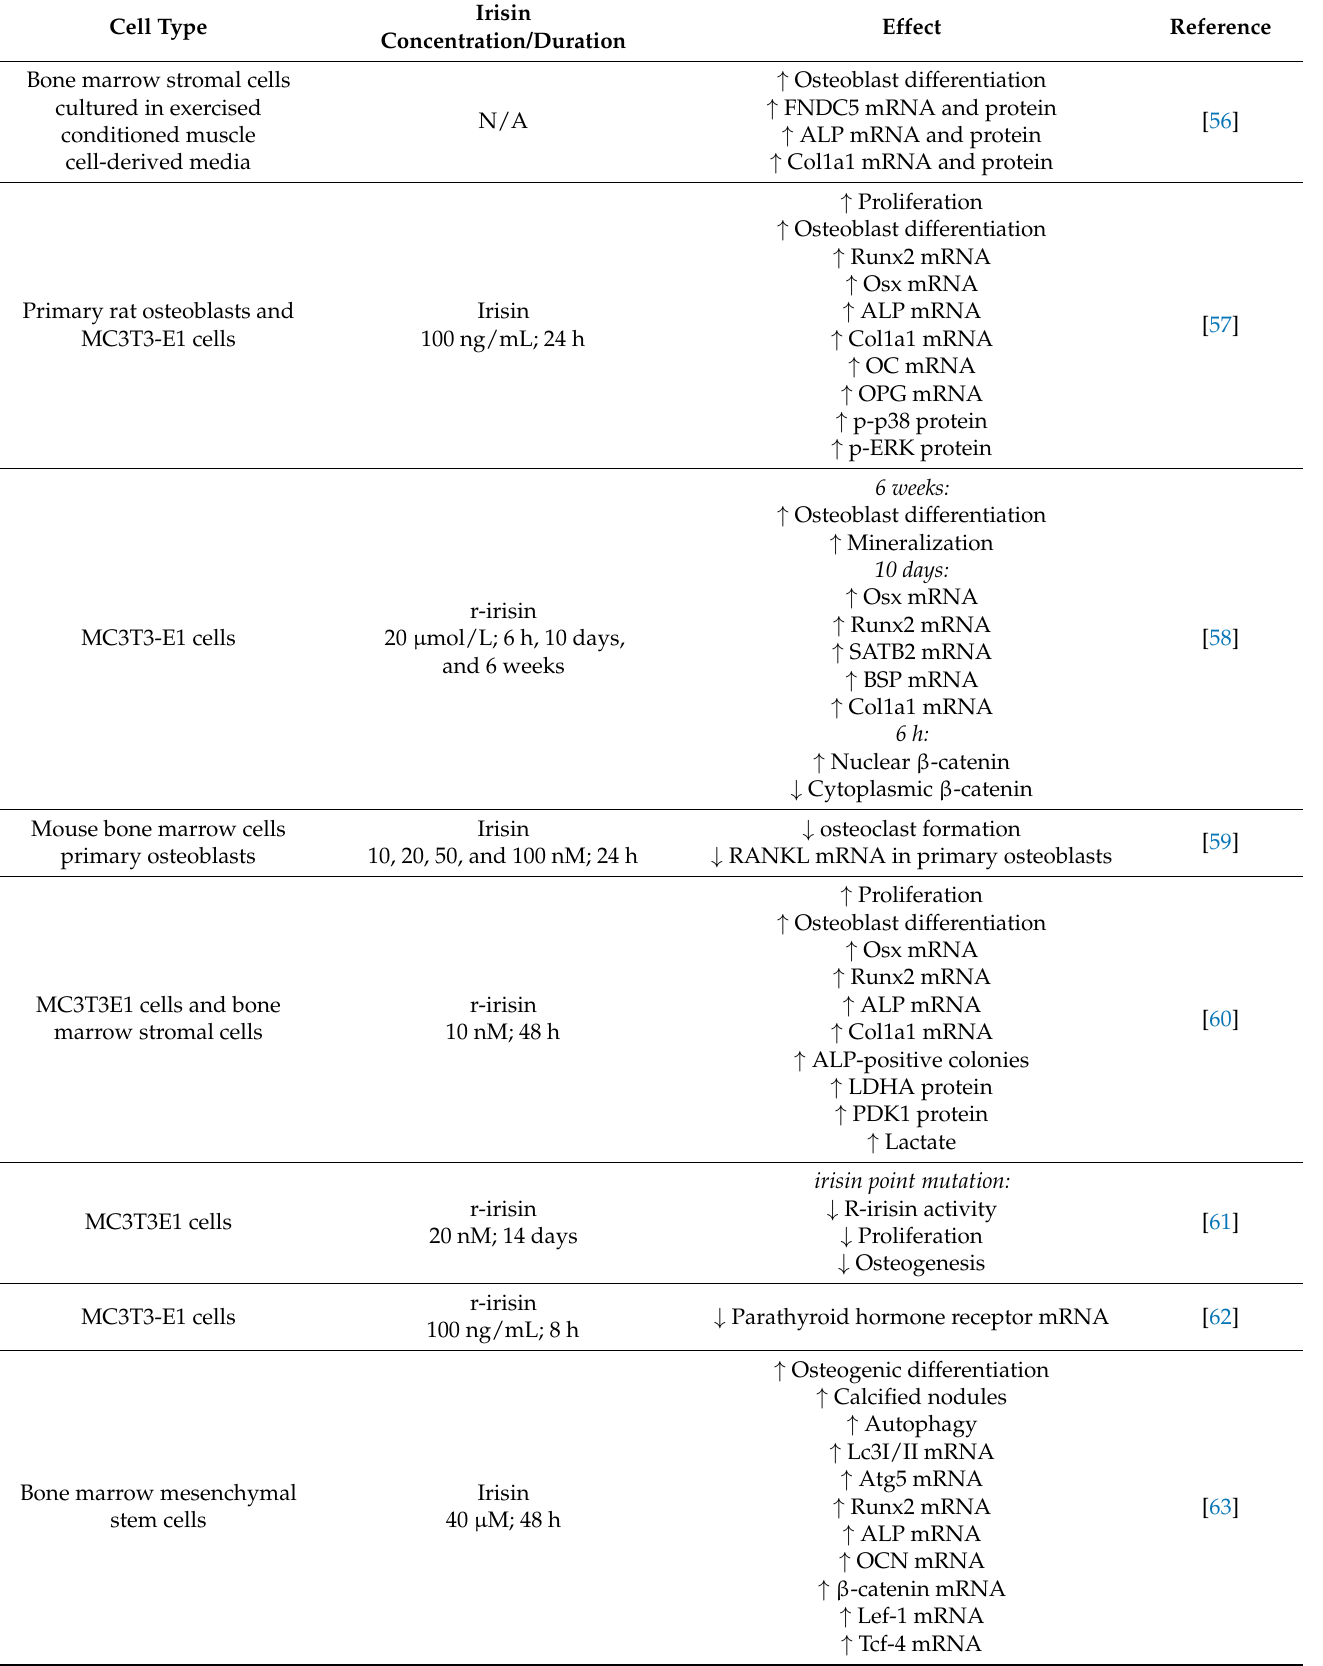
Table 1. Role of Irisin on Osteoblasts: in vitro